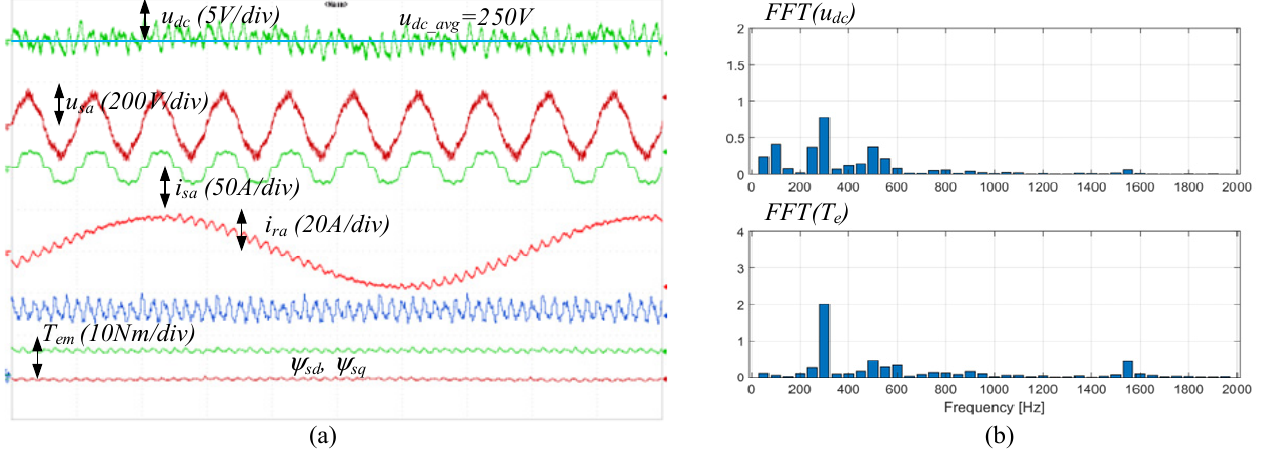
Figure 11. Experimental results of a small-power DFIG-DC system for the proposed direct torque control DTXC ( a ) and the FFT results of DC-bus voltage and torque oscillations for this method ( b ).